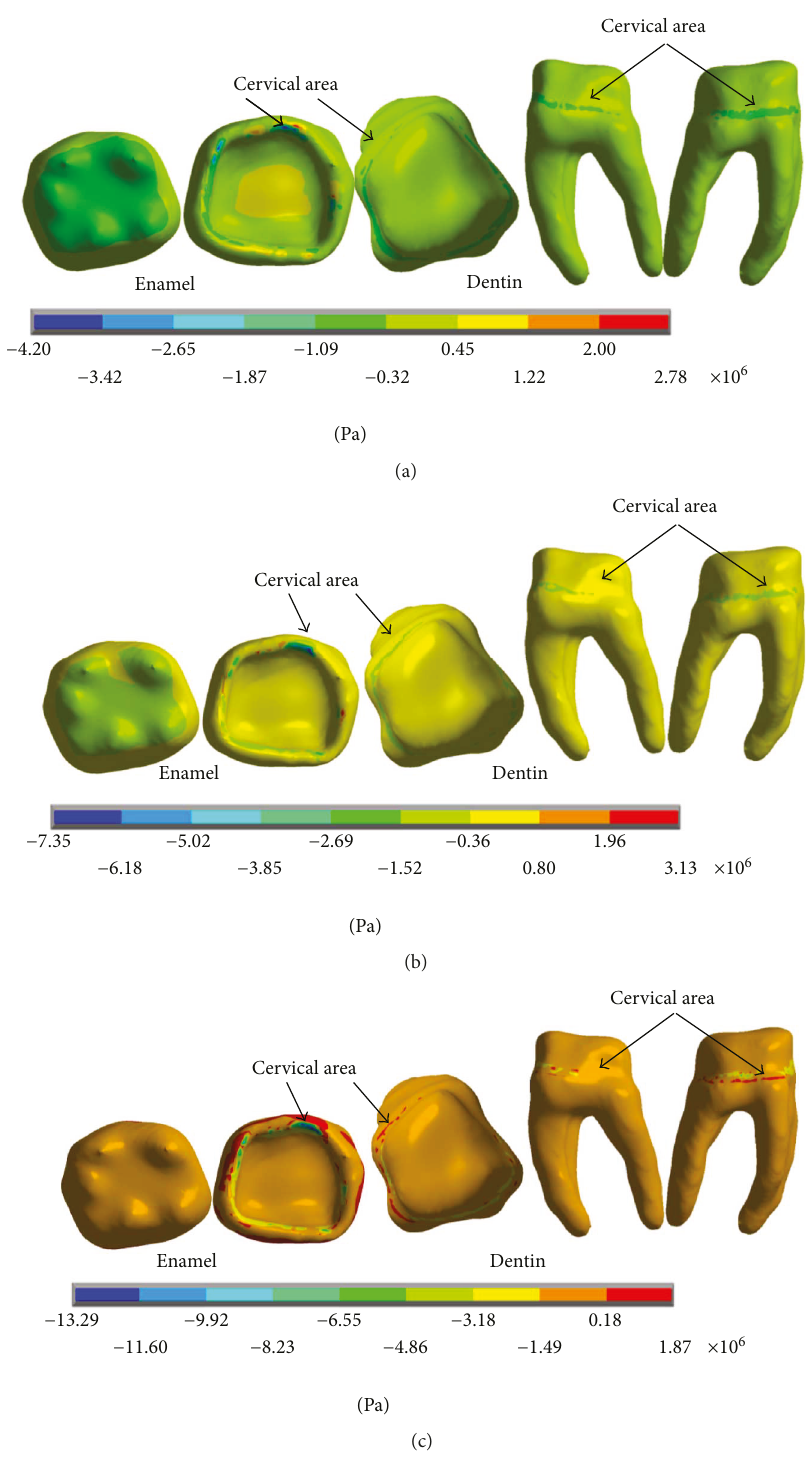
Figure 20: Nominal stress of the contact simulation. (a) x -axis. (b) y -axis. (c) z